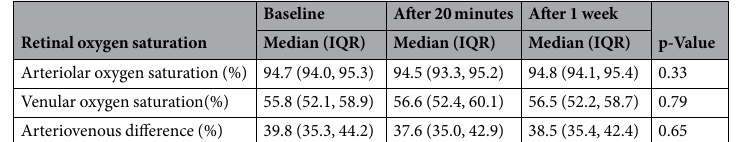
Table 2. Median Retinal Oxygen Saturation Values between the Visits. IQR, interquartile